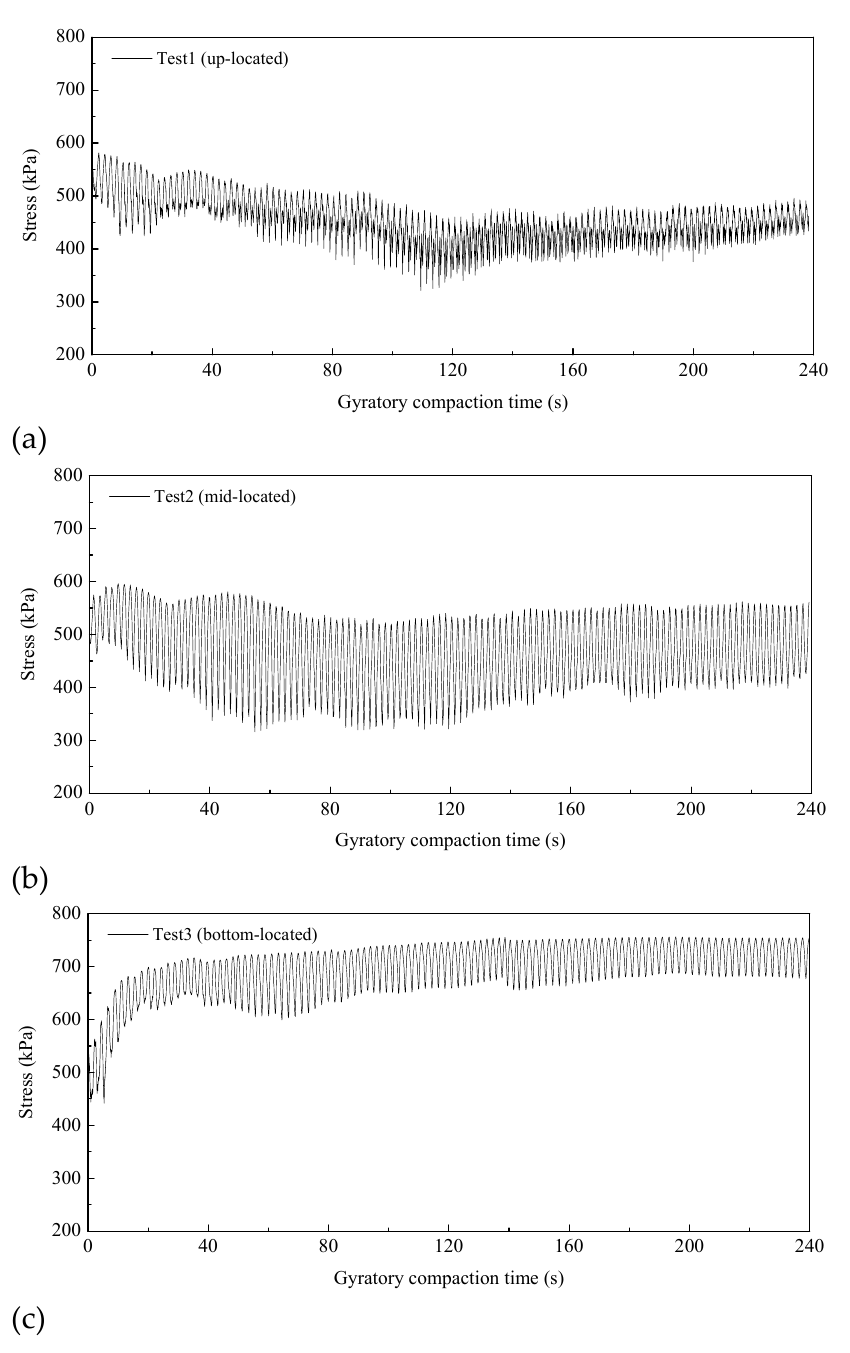
Figure 9. Particles’ contact stress tested by SmartRock located in ( a ) upper, ( b ) middle and ( c ) bottom positions of the